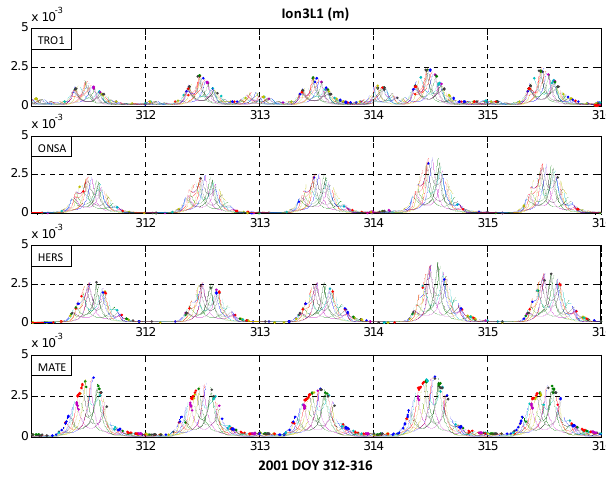
Fig. 3. Ion2 (m) for GPS L1 (Ion2L1) for the observation stations on DOY 312‐316 in 2001.